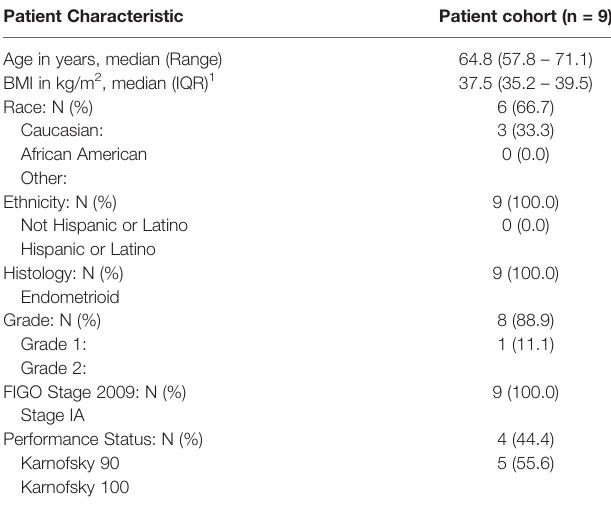
TABLE 1 | Patient Demographics. Patient Characteristic